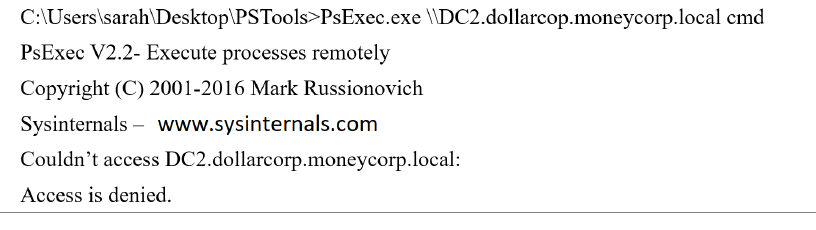
Figure 8. Access Denied on Domain Controller.